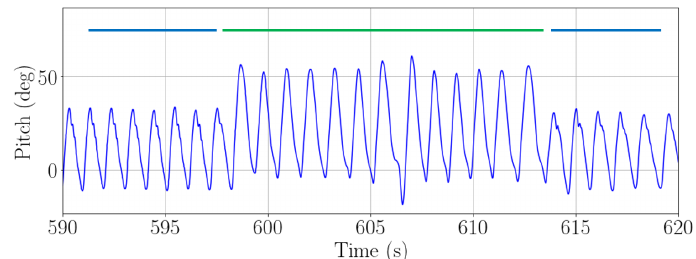
Figure 9. Detection of vertical displacement in stairs with the pitch angle. The green solid line above the pitch estimation indicates the moment when the passenger is climbing a staircase. The blue solid line indicates the moment when the passenger is walking on a horizontal surface.